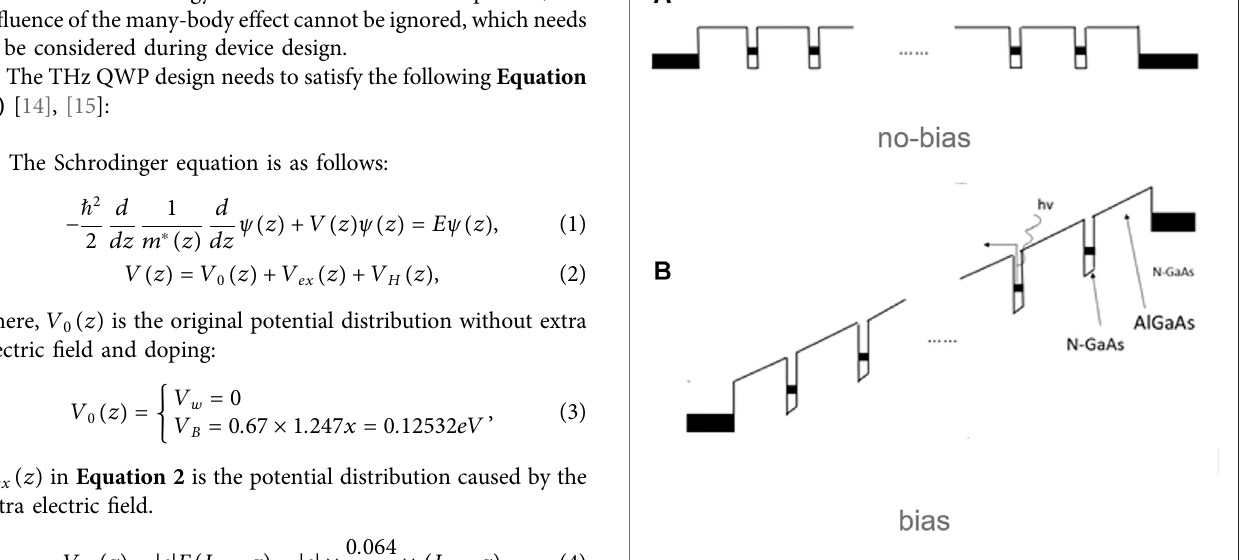
FIGURE2| THz QWPenergybandstructure. (A) Nobias; (B) With